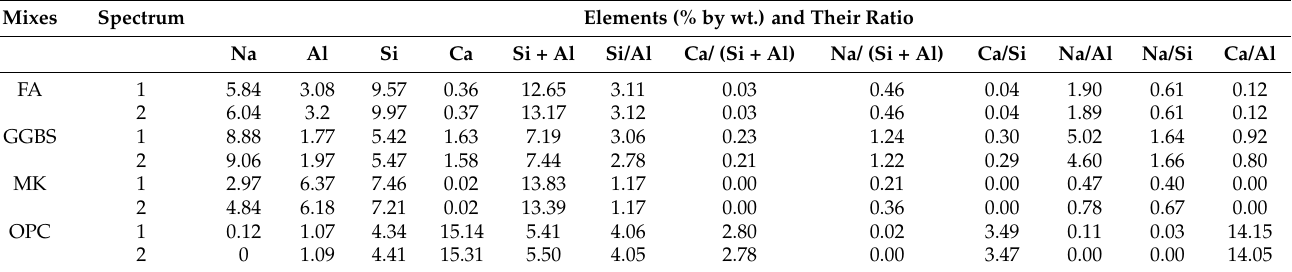
Table 5. EDS analysis of alkali-activated